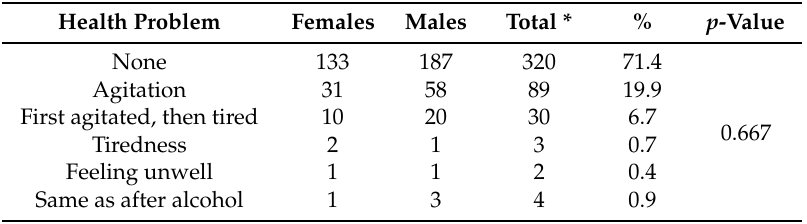
Table 5. Health problems reported by students after EDs consumption.